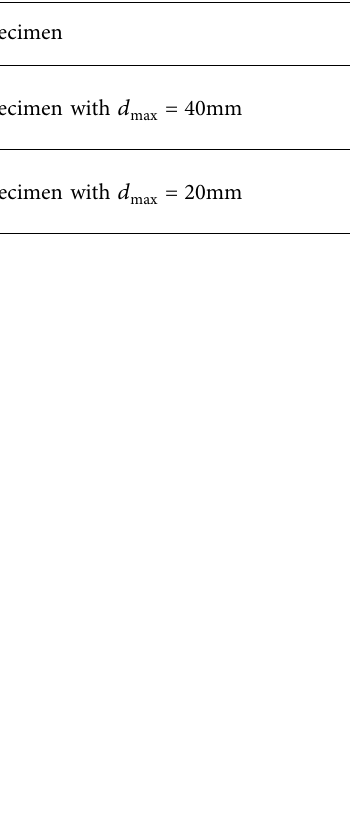
Table 3: Specimen gradation.